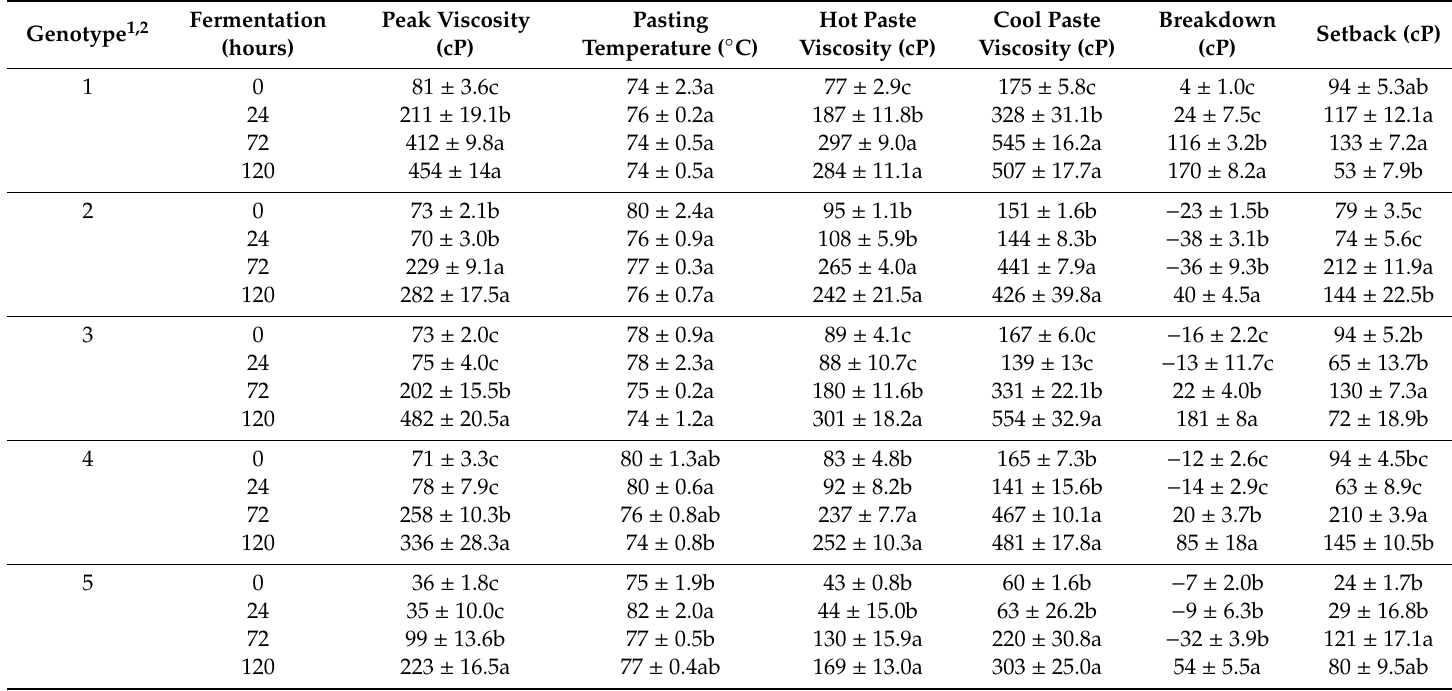
Table 4. E ff ect of steeping on the final viscosity of the biofortified maize flours from hot flour in water dispersion using a rapid visco-analyzer (RVA) model RVA-4 series. Genotype